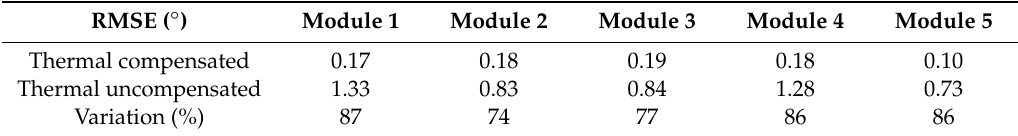
Table 2. RMSE calculated on the basis of data acquired in natural, uncontrolled temperature variation conditions in the range between 5 and 40 ◦ C. The table provides both RMSE derived by thermally compensated and uncompensated measurements and variation of the RMSE after compensation.